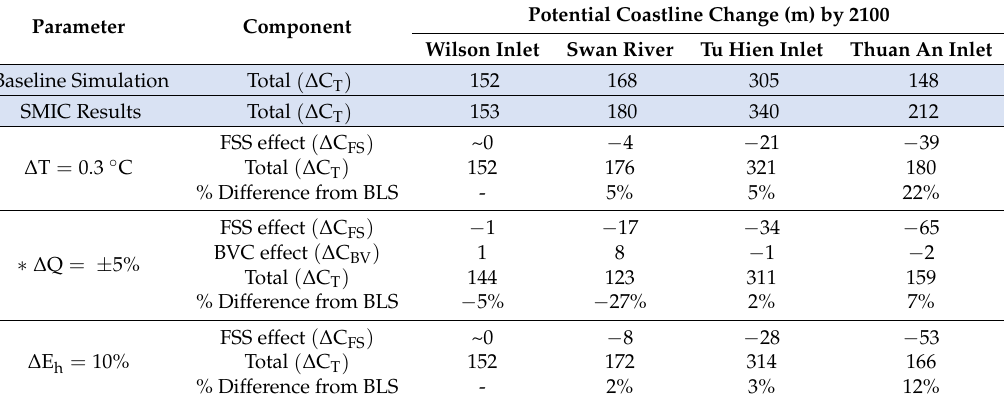
Table 5. Modelled coastline changes by 2100 under different climate-change and anthropogenic forcing scenarios